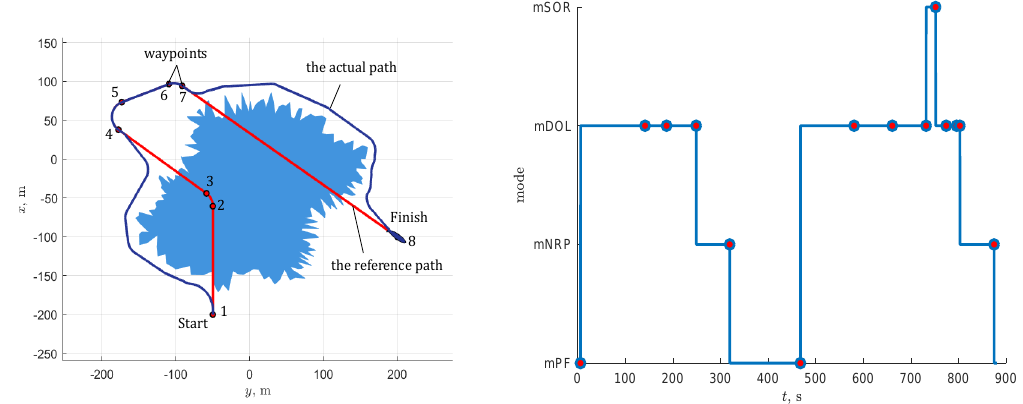
Figure 9. Simulation results for Scenario 1: sharp-edged obstacle environment. On the left, the blue area corresponds to the obstacle on the ( x , y ) plane, the red line represents the AUV’s reference path, and the blue line represents the actual trajectory obtained by the simulation; marks on the red line are points connecting two adjacent segments of the reference path. On the right, the blue line shows the change in the state of the designed discrete event system and red marks on the line indicate moments when a new path is